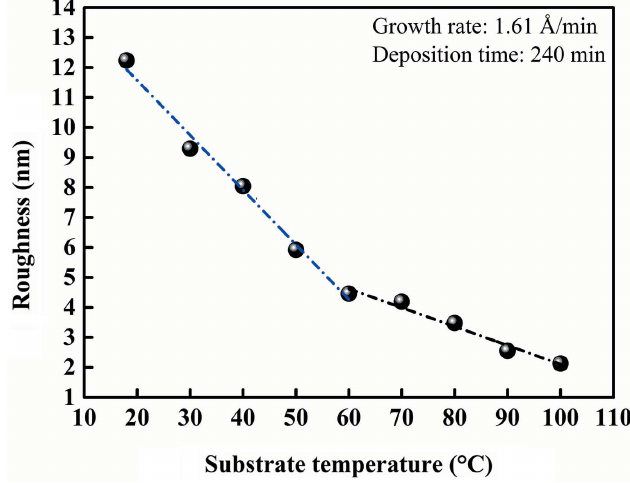
Figure 5 The RMS roughness as a function of Bi thin films for substrate temperatures (the growth rate is 1.61 A˚ min (cid:5) 1 and the deposition time is 240